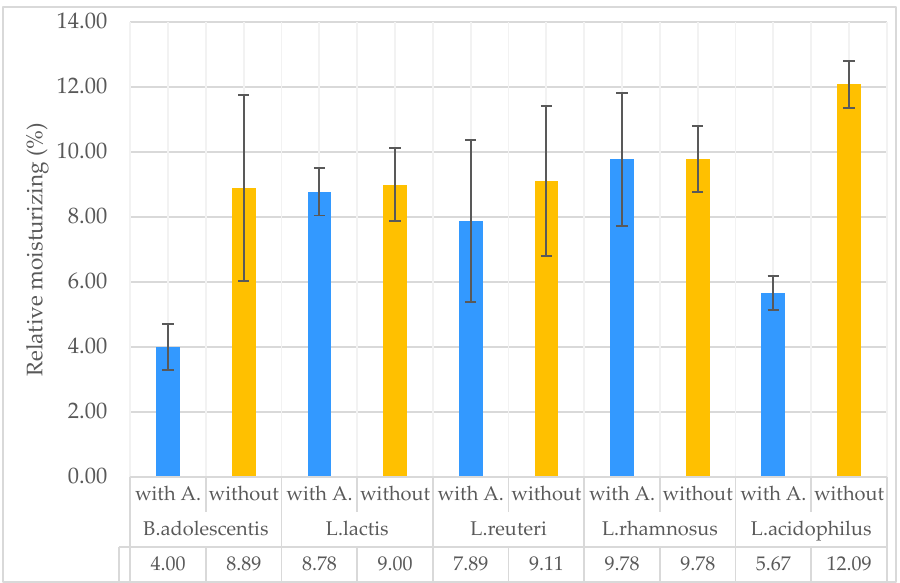
Figure 4. The ferment filtrates rel. moisturising in a steady state. (with A. = fermentation media included alginite and without = the fermentation media did not include alginite).